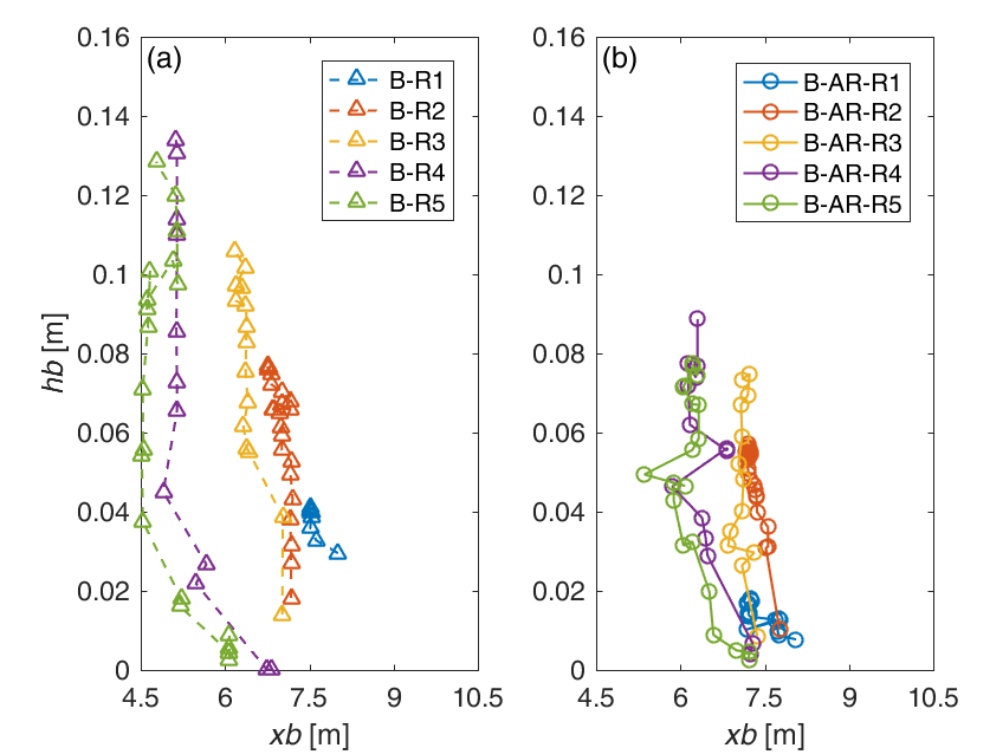
Figure 7. Maximum deposition thickness hb and its cross-shore location xb during beach evolution under regular waves: ( a ) B tests; ( b ) B-AR tests (The values are derived from profiles in Figure 6, hence the time intervals of the triangles or circles are 5 min for R1, 1 min for R2 and R3, 20 sec for R4, and 10 sec for R5).